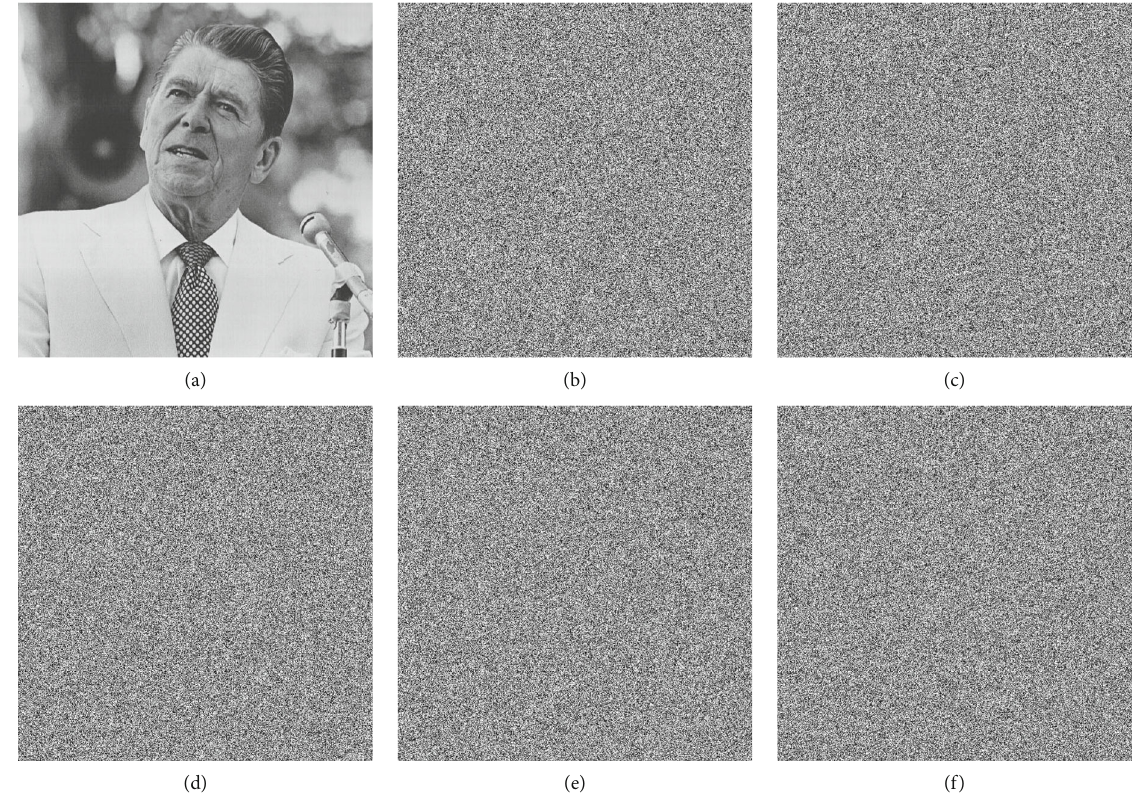
= 0 : 65478466897887 + 10 − 15 . (c) Decrypted 0